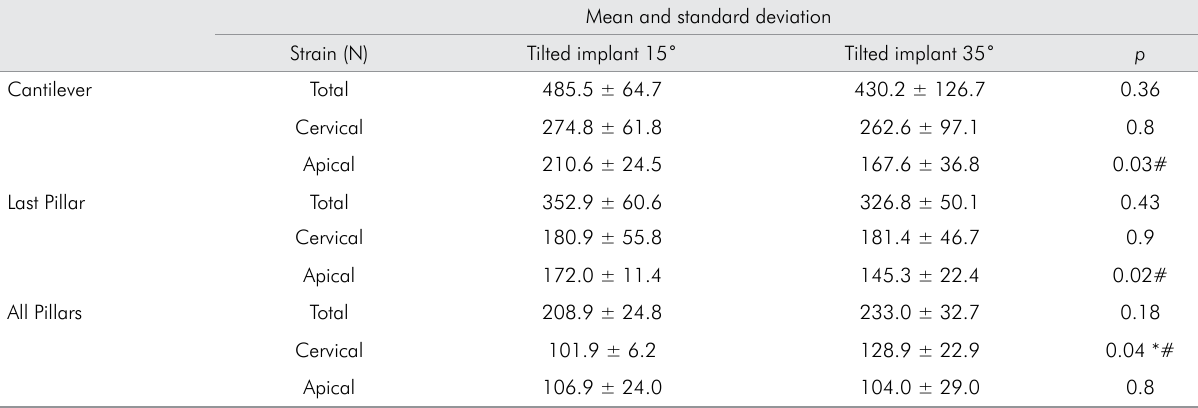
Table 1. Shear stress mean to the two groups in three loads simulation.